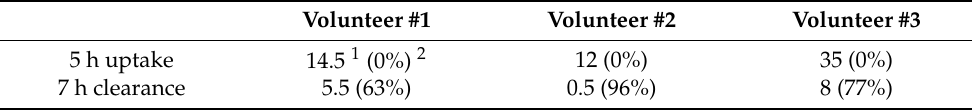
Table 1. Amounts of 3-CetylAA in the stratum corneum after uptake and